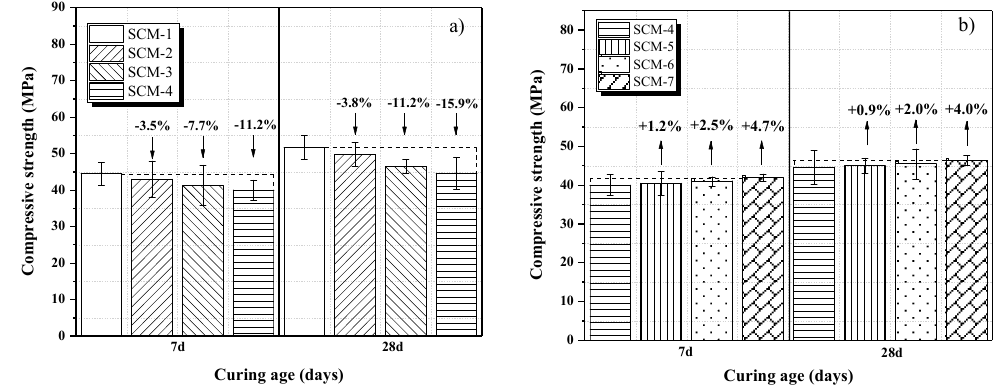
Figure 4. Results of compressive strength tests of SCM samples at varying ( a ) coral sand replacement rates and ( b ) PVA fiber contents.